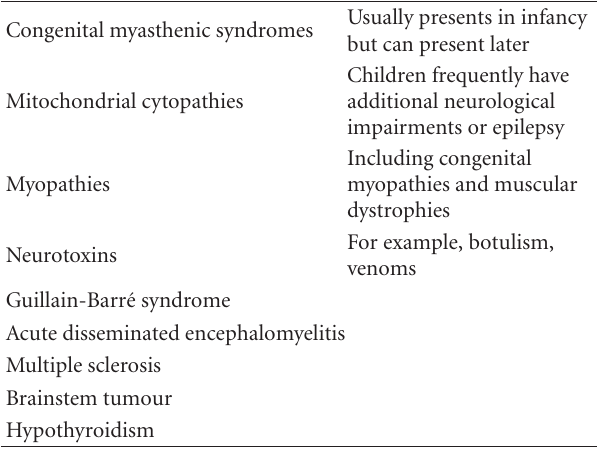
Table 2: Di ff erential diagnosis of